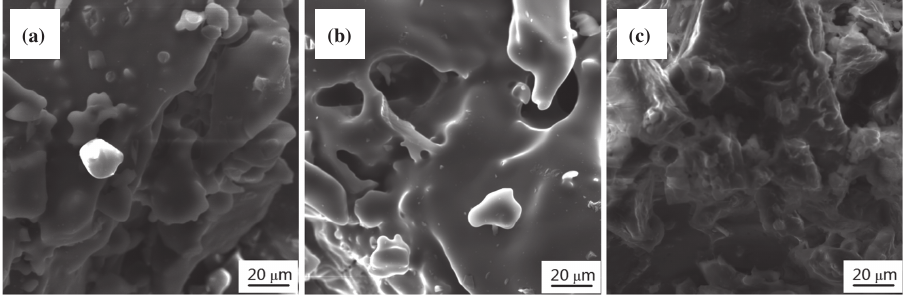
Figure 4: Typical SEM images of the B-Si-doped carbon materials obtained by carbonization treatment at different temperatures after